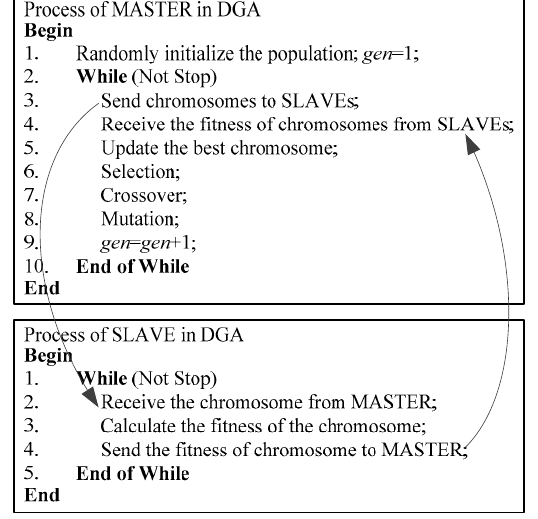
Figure 4. The flowchart of the DGA for solving the energy efficient coverage (EEC) problem in the wireless sensor networks (WSN).